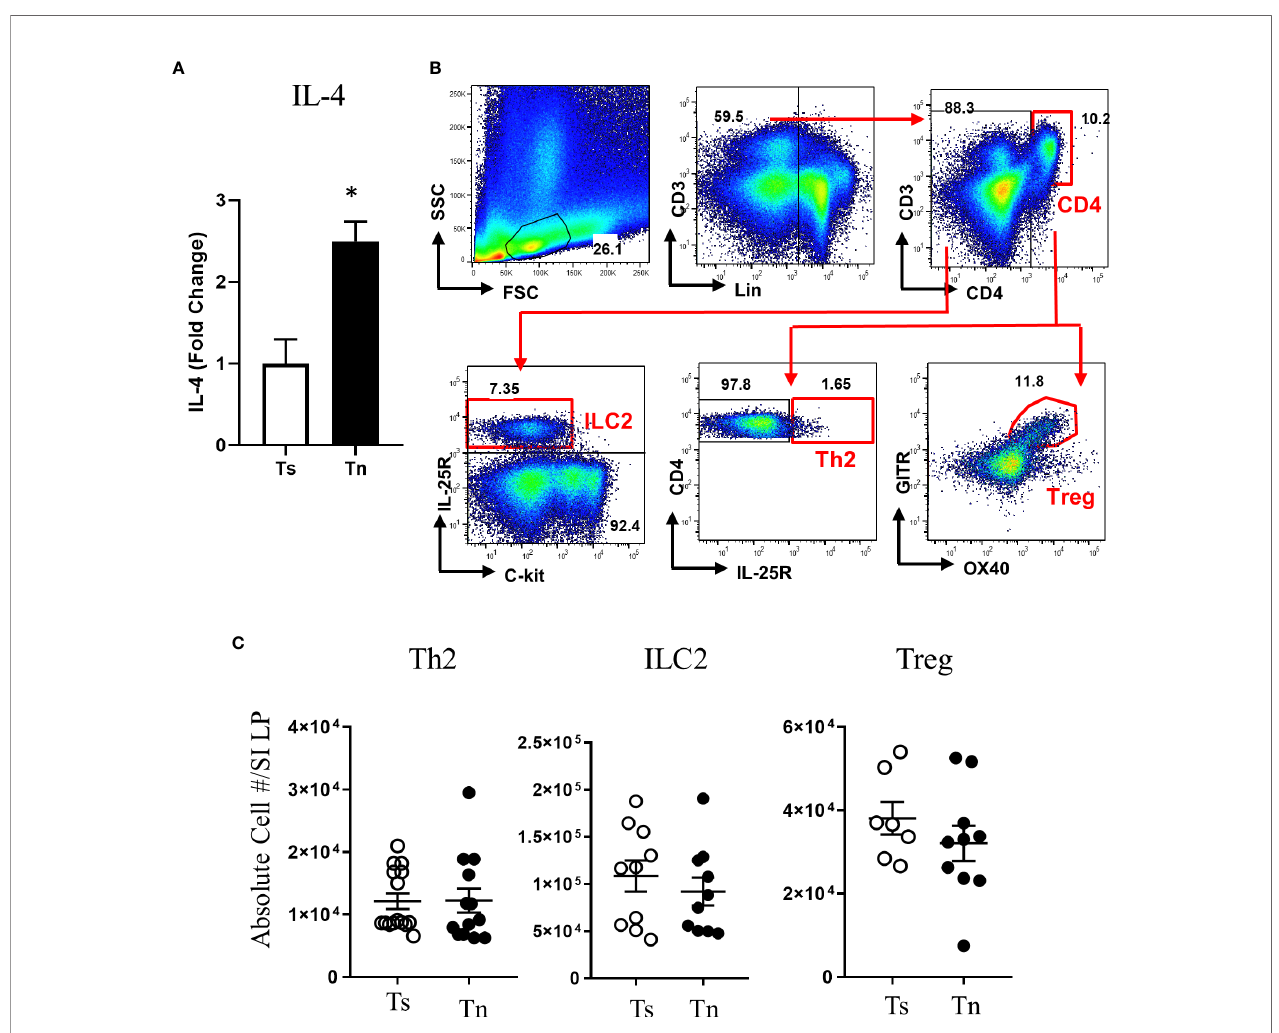
FIGURE 3 | Thermoneutral housing has minimum effects on the gastrointestinal immune cells in Il4ra F709 mice. (A) serum IL-4 was assessed by in vitro cytokine capture assay (IVCCA) in Ts and Tn housed Il4ra F709 mice. (B) Gating strategies for fl ow cytometry analysis of the small intestinal lamina propria for ILC2, Th2 and Treg. (C) Flow cytometry analysis of small intestinal lamina propria for CD4+ Th2 (Lin - CD3 + CD4 + IL17RB + ), ILC2 (Lin-CD4-CD8-ckit-IL17RB+), and Treg (Lin - CD3 + CD4 + GITR + OX40 + ) from Ts and Tn housed Il4ra F709 mice. These immune cells were identi fi ed with the panel of markers described in Table 1 and presented as the absolute cell number in the lamina propria (LP) of the small intestine (SI). n=5 per group for (A) . n=7-10 per group for (B) . * denotes statistical signi fi